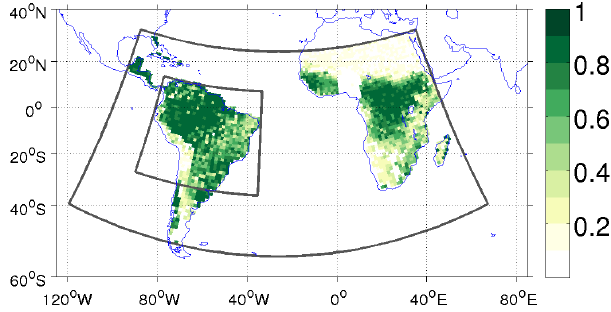
Figure 3. Land surface albedo (fraction) and locations of the coarse (140km resolution) and nested (35km resolution) domains for WRF-Chem